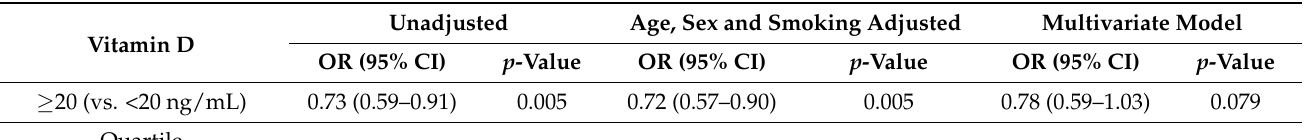
Table 4. Multivariate analysis for the association between vitamin D and